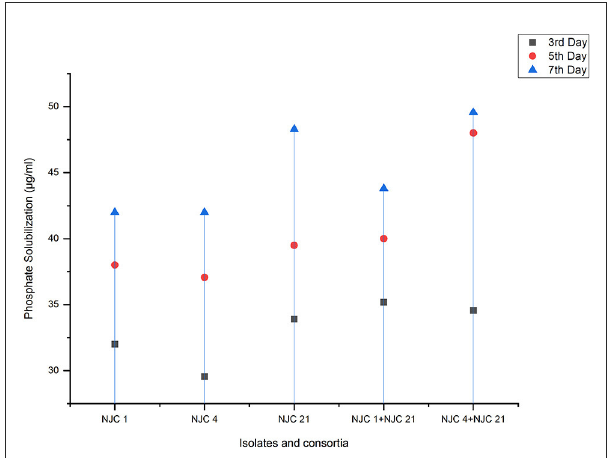
FIGURE4 Phosphate Solubilization by isolates and